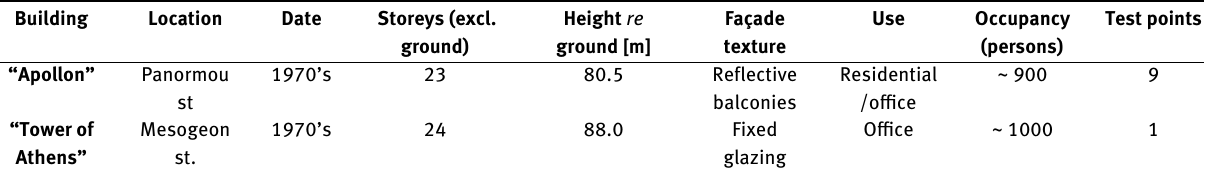
Table 1: Basic details of the test buildings Building